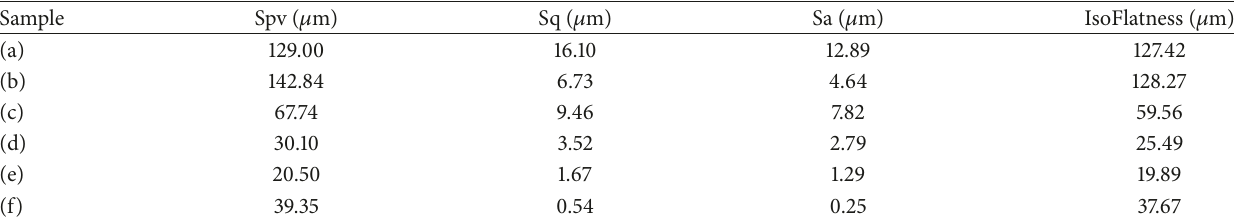
Figure2:Roughnessof3DprintedV-bandhorns’innersurfaces:(a)binderjetted316Lstainlesssteelwithouttreatment,(b)goldelectroplated binder jetted 316L stainless steel, (c) MMP treated binder jetted 316L stainless steel, (d) manually polished SLM Cu-15Sn, (e) gold electroplated SLM Cu-15Sn, and (f) MMP treated SLM Cu-15Sn. Table 1: Measured inner surface roughness of V-band